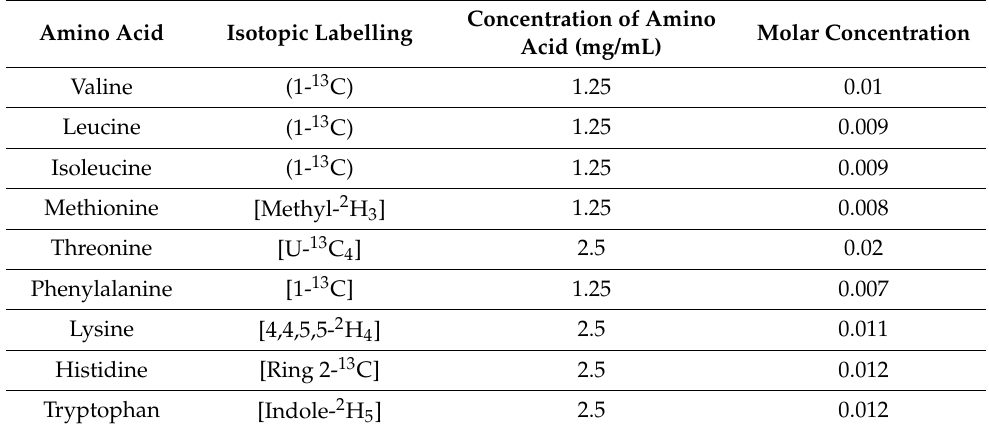
Table 1. Composition of the